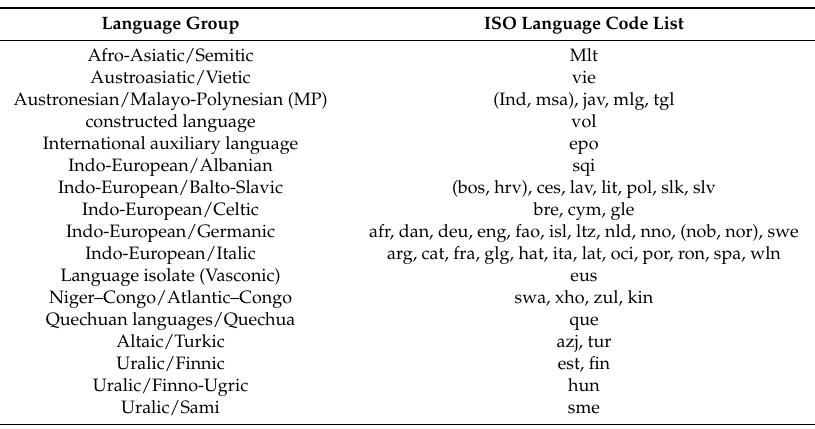
Table 2. Latin script